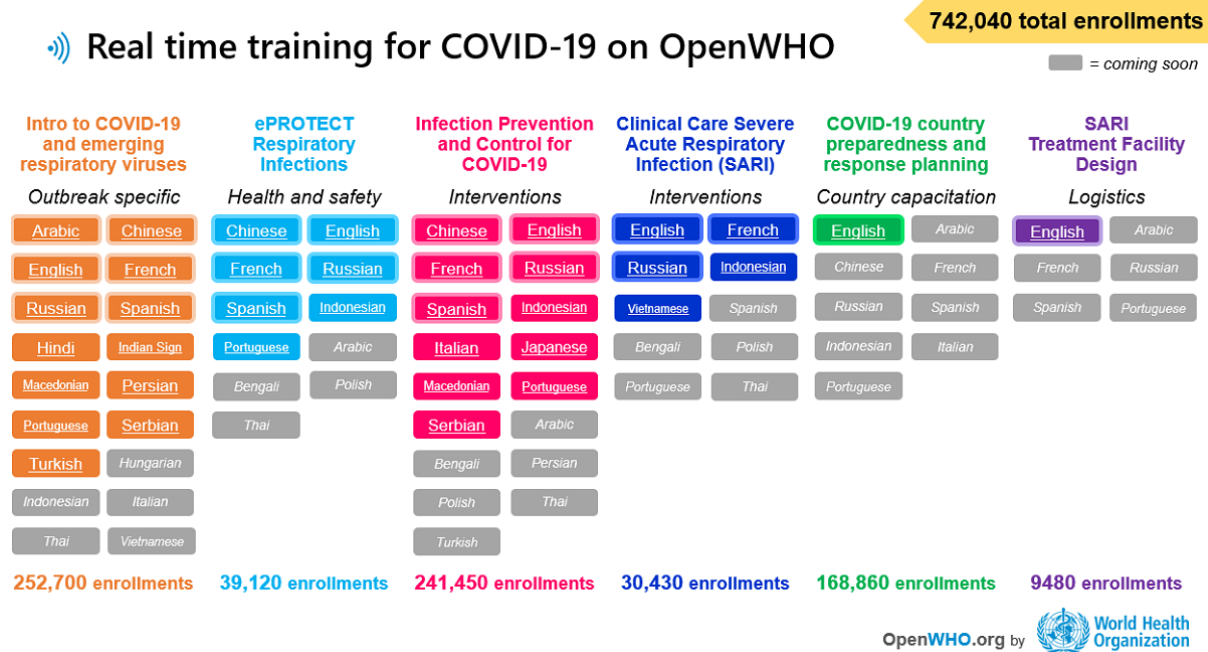
Figure 9. OpenWHO courses related to COVID-19 and language versions as of March 27, 2020. COVID-19: coronavirus